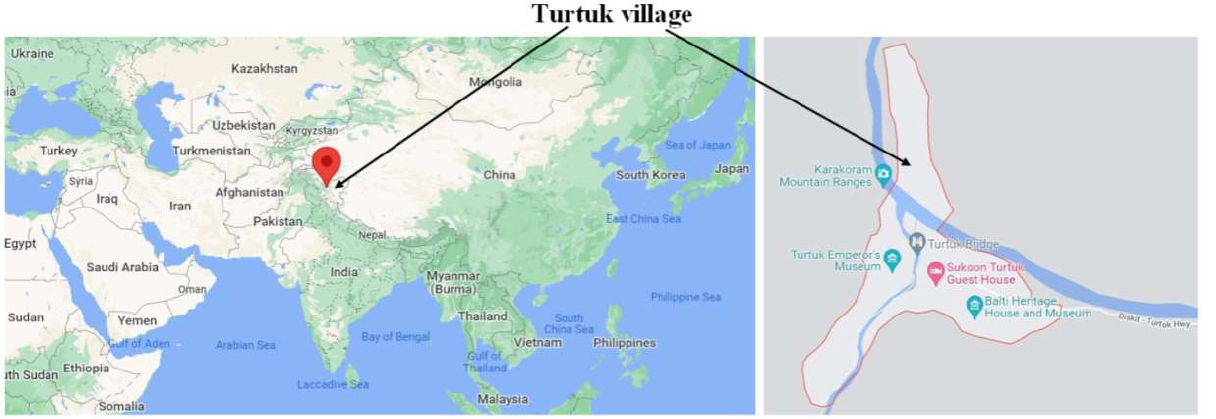
Figure 1. Map showing Turtuk village in Ladakh,